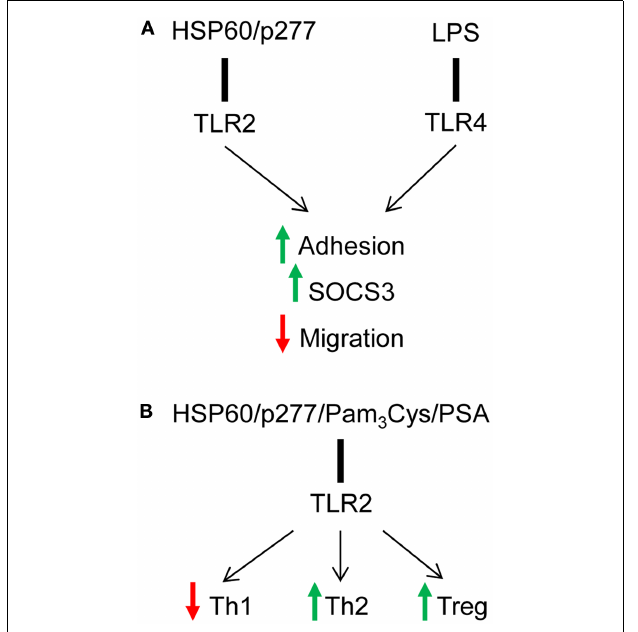
FIGURE 1 | Signaling viaTLR2 andTLR4 directly down-regulatesT cell effector function . (A) HSP60 viaTLR2 and LPS viaTLR4 induceT cell adhesion and down-regulateT cell chemotaxis in SOCS3-dependent mechanism. (B) TLR2 signaling induced by several endogenous and pathogen-derived ligands shifts cytokine profile towardTh2-like phenotype and up-regulates the suppressive function ofTregs.